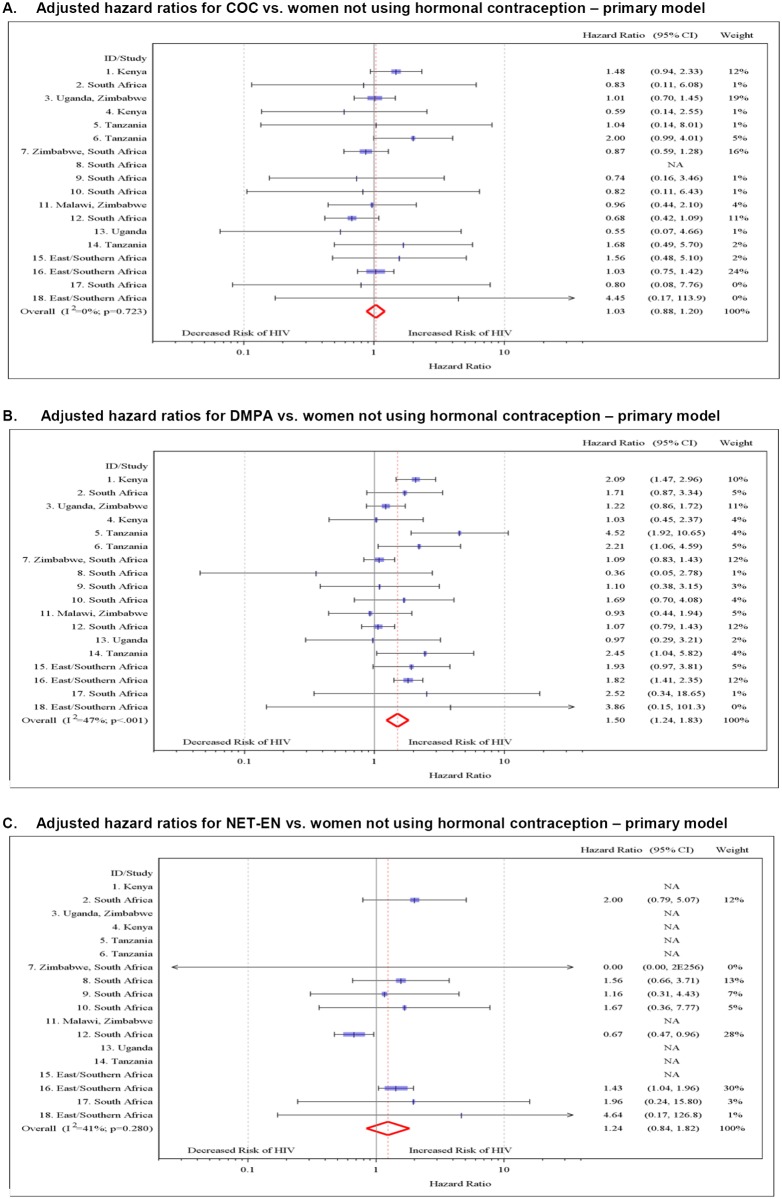
Multivariable associations between hormonal contraceptive use and HIV acquisition by study, with non-hormonal-contraceptive group as the reference.(A) aHRs for COC use versus no HC use—primary model. (B) aHRs for DMPA use versus no HC—primary model. (C) aHRs for NET-EN use versus no HC—primary model. Individual study results from Cox regression modeling. Pooled aHRs from random effects meta-analysis adjusted for age, married/living with partner, number of sex partners, condom use, and region (east Africa, southern Africa, and South Africa). Each horizontal line represents the 95% confidence interval around the HR. Shaded areas represent the comparative weight of each study. No estimate was possible if there were not events in the specified contraceptive group. NA, not applicable.